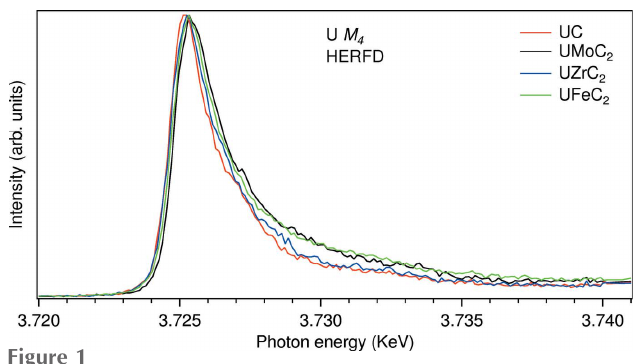
Figure 1 U M 4 HERFD-XAS spectra of uranium carbides.